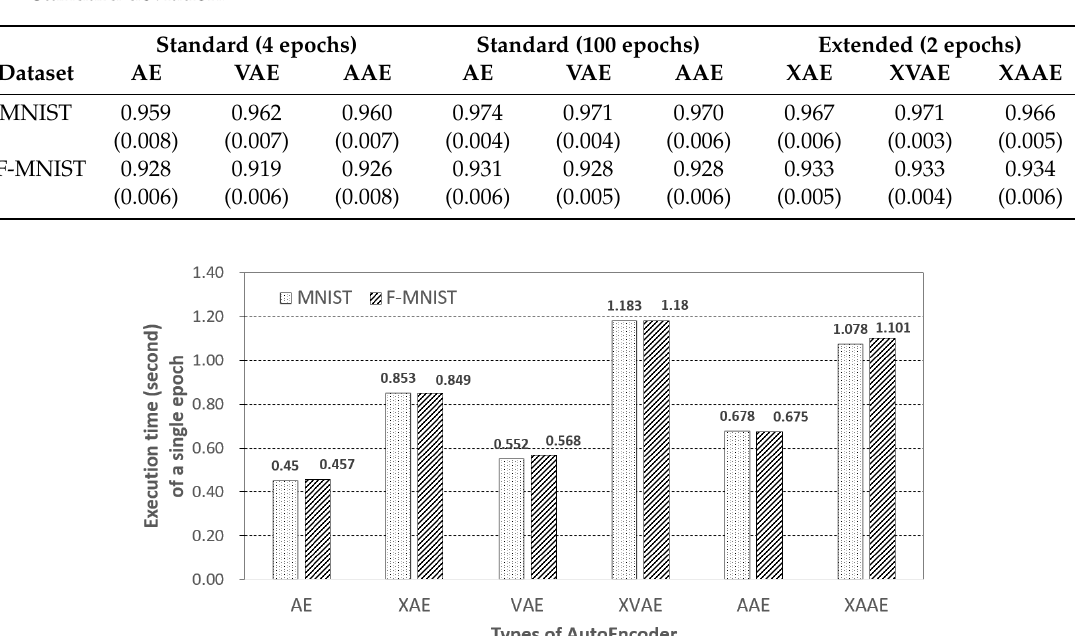
Table 5. AUROC of RaPP with benchmark datasets. The number of in parenthesis indicates the standard deviation.